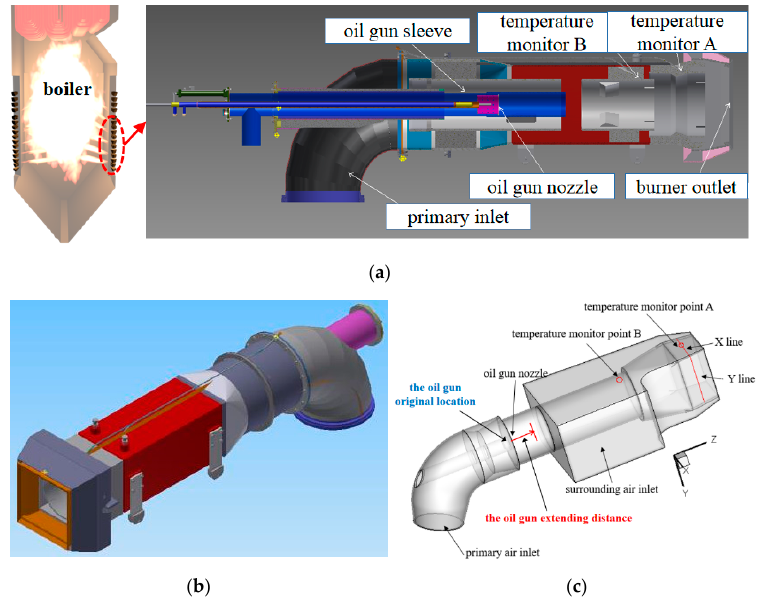
Figure 1. Tiny oil ignition burner structure. ( a ) Schematic diagram of the burner’s components, ( b ) burner’s geometry, ( c ) 3D model for numerical simulation.